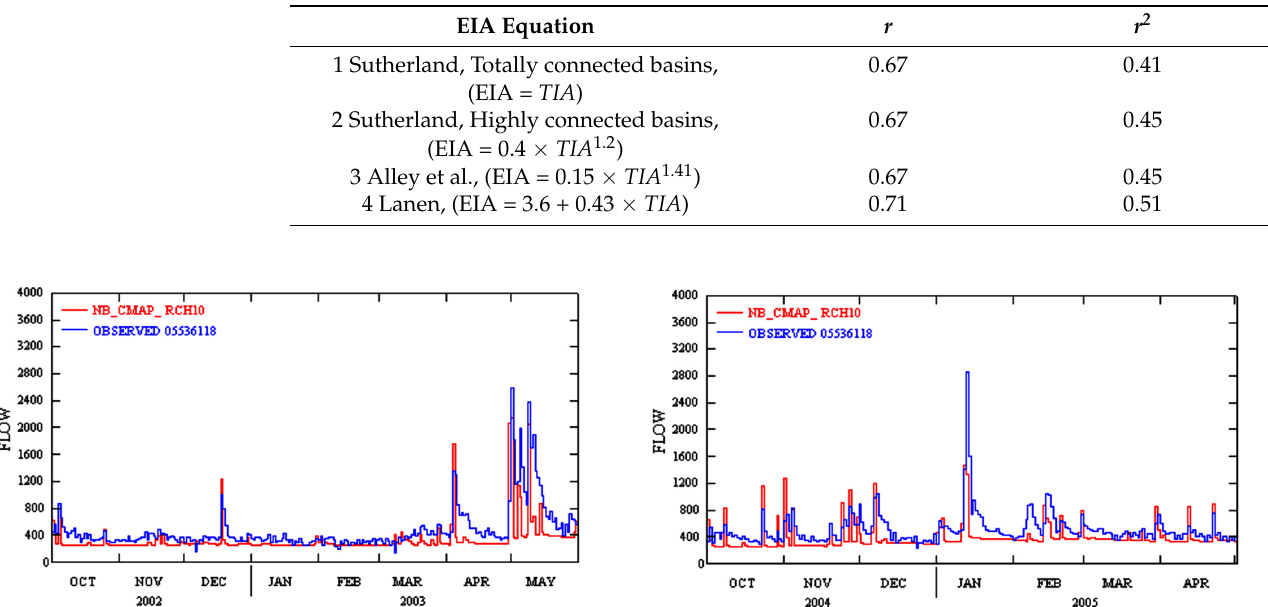
Table 5. Sensitivity analysis for EIA equations.